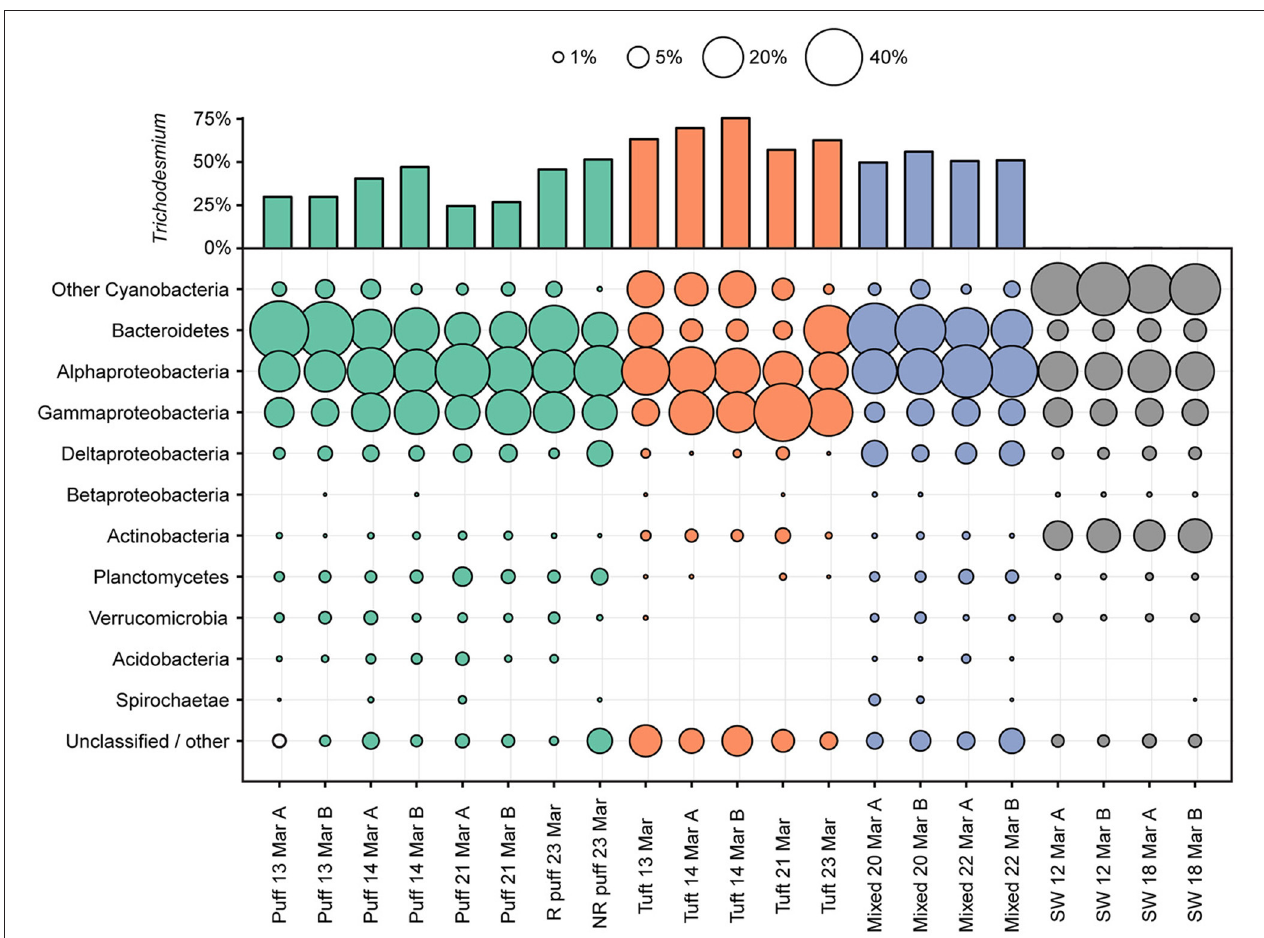
FIGURE 4 | Percentages of partial 16S rRNA gene sequences assigned to bacterial taxa. Percentages of sequences assigned to Trichodesmium are displayed in the upper bar plot. The area plot displays the percentages of non- Trichodesmium sequences assigned to other bacterial taxa. Color indicates the sample type/morphology [green, red, blue, and gray for puff colonies, tuft colonies, mixed colonies, and bulk 25m seawater (SW), respectively]. R denotes radial and NR denotes non-radial puff morphologies (see Figure 1 ).